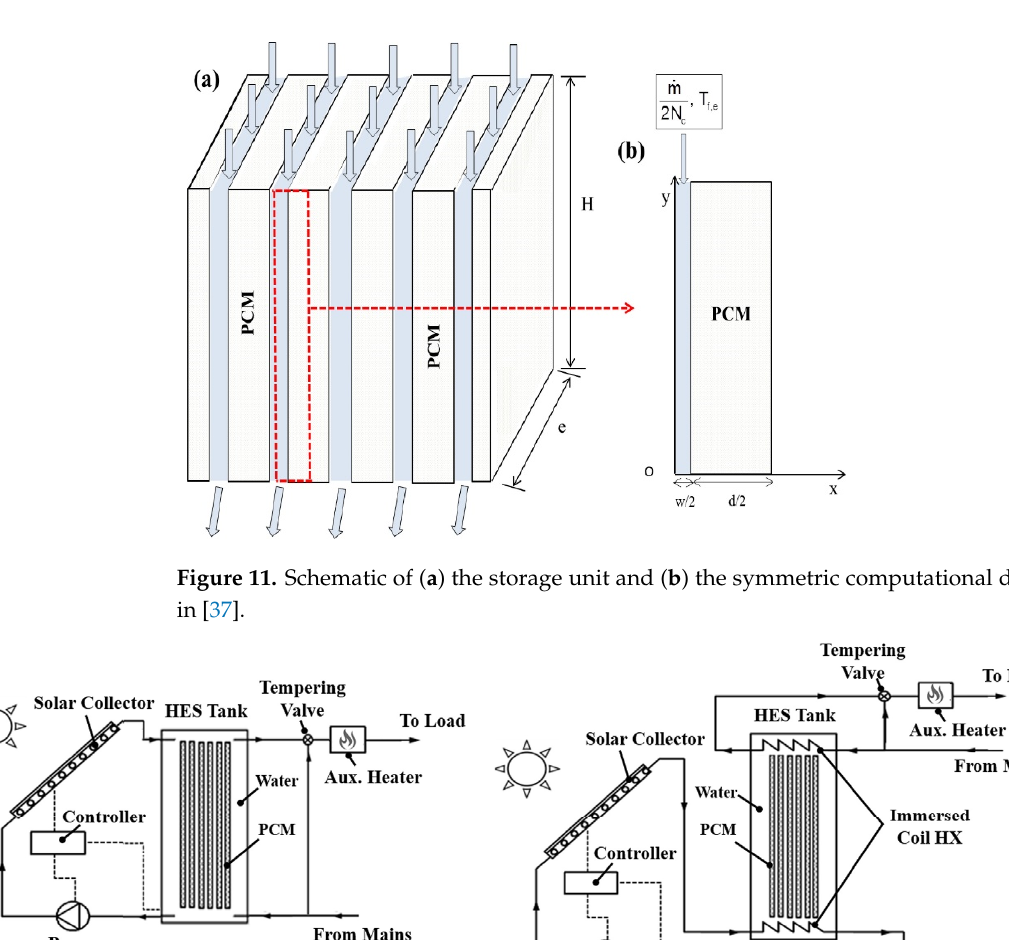
( c ) Figure 10. The layout of the storage tanks with an aspect ratio of ( a ) 1:1, ( b ) 3:1, and ( c ) 2:1 [35]. Apart from these studies, research was also carried out on different shaped containers and configurations. Numerically, Elbahjaoui and Qarnia [37] investigated the rectangular LHTES (Figure 11) integrated with solar collectors and observed the outlet water temperature in the range of 43.6–24 °C, 51.7–24 °C, and 62.86–24 °C, respectively, for RT42, RT50, and RT60 during discharging. Abdelsalam et al. [38] examined direct and indirect heat-exchange modes in the water storage tank and hybrid storage (water + PCM modules) tanks, as depicted in Figure 12. The direct mode operated with a higher solar fraction than the indirect mode due to thermal stratification. To further improve the system, the authors